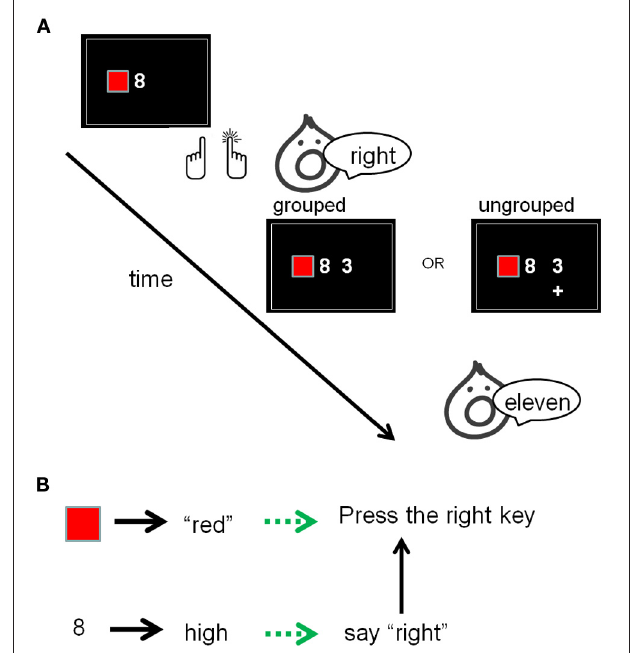
FIGURE 5 | Ellenbogen and Meiran’s (2011) fourth experiment. (A) Stimuli 1 and 2 were first presented, then Responses 1 (key press) and 2 (vocal) were given, then Stimulus 3 was added, then Response 3 was given. The color in Stimulus 1 indicated if Task 3 was addition or subtraction (or the + / − sign in the ungrouped condition). (B) The representation of the instructions for Tasks 1 and 2 according to our framework were held as a blend of activated long-term memory (the concepts written in black as well as overlearned links between them) and region of direct-access